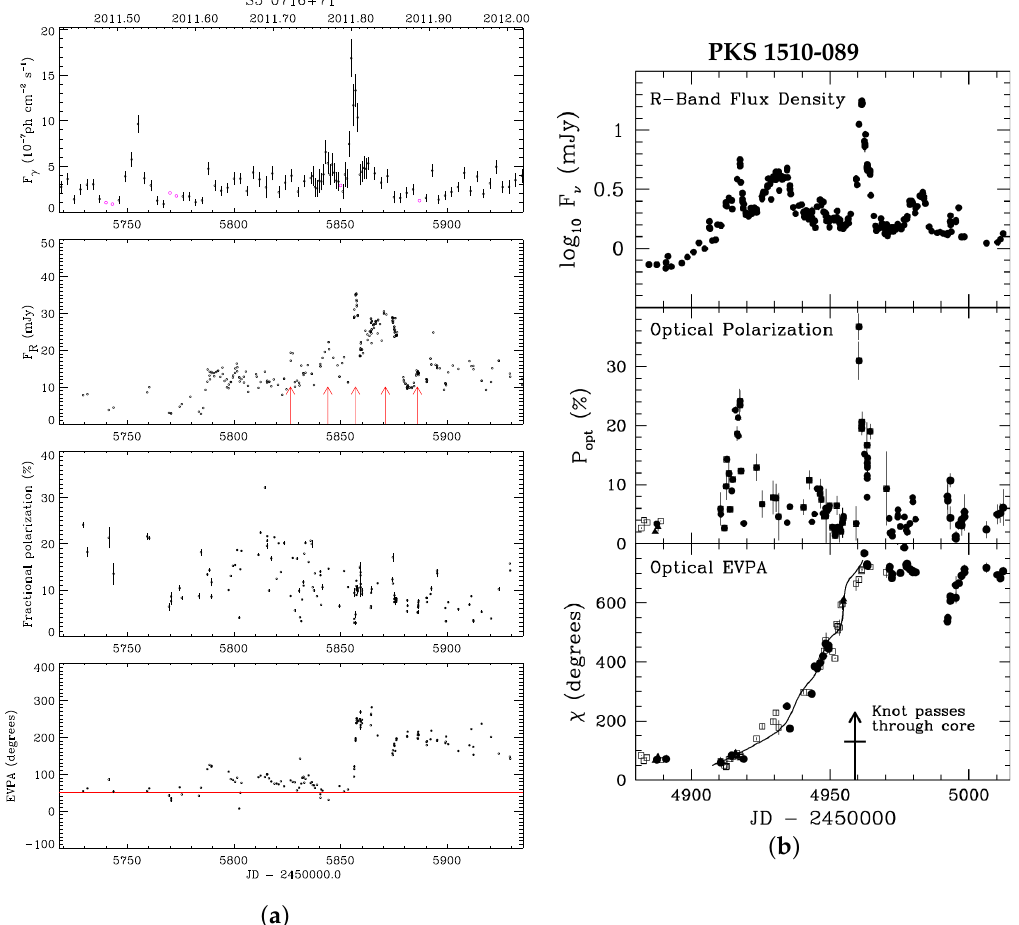
Figure 2. ( a ) From top to bottom: Fermi γ -ray flux, optical R-band flux, optical fractional polarization, and position angle of polarization for S5 0716+71 during the outburst of October 2011 [5]. Red vertical arrows mark positions of subflares; ( b ) Optical flux and polarization parameters of PKS 1510-089 during an outburst in 2009